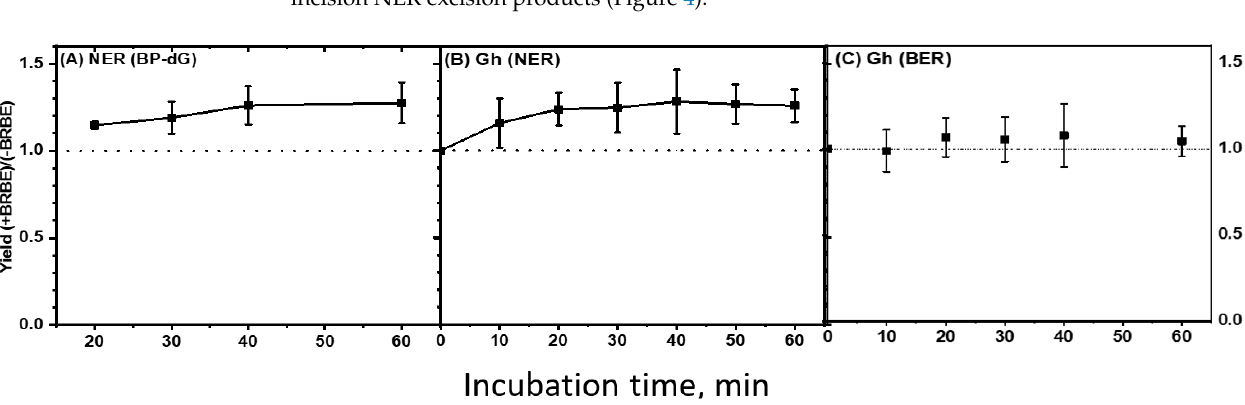
Figure 6. Time dependence of the ratios of NER product yields, [Y(+BRBE)/Y( − BRBE)] as a function of incubation time. ( A ). NER, BP ‐ dG adduct. Each time point represents the average and standard